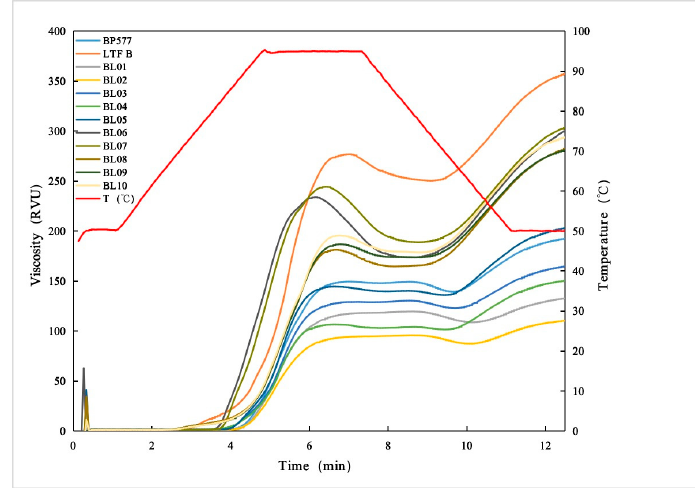
Figure 4. Rapid viscosity profiles of rice starches. Table 5. Pasting properties of rice starches.